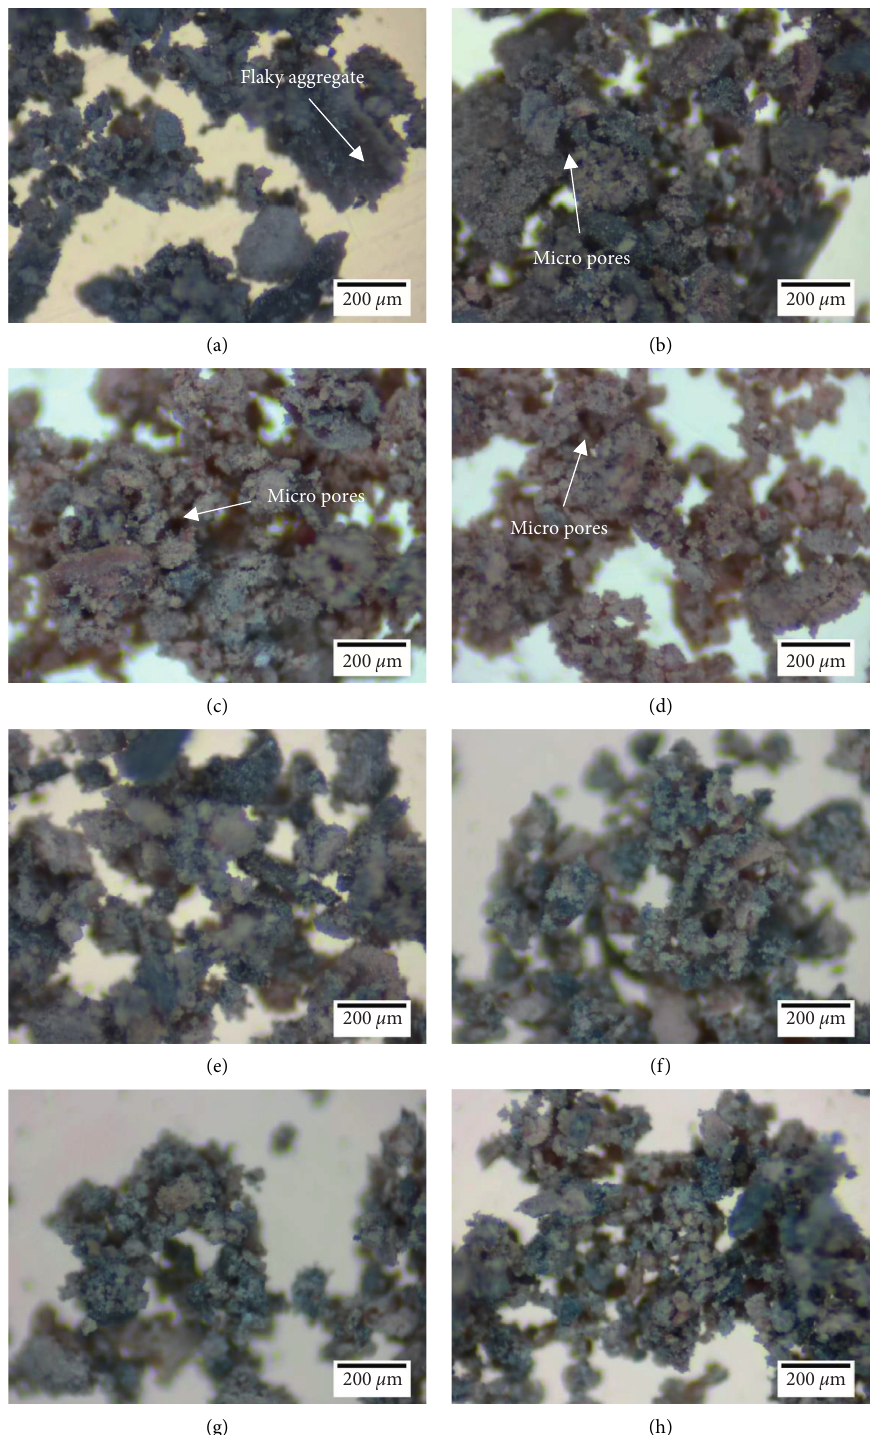
Figure 4: Evolution of microstructure of slaking mudstone at × 400 magnification. (a) 5min, P / D � 0.04; (b) 10min, P / D � 0.06; (c) 15min, P / D � 0.07; (d) 20min, P / D � 0.09; (e) 30min, P / D � 0.13; (f) 40min, P / D � 0.15; (g) 50min, P / D � 0.17; (h) 60min, P / D � argillization wear stage, and secondary wear stage. The of slacking mudstone stage, and adhesion of slacking mudstone mechanisms of argillization and cutter wear considering stage. Correspondingly, due to the argillization in mudstone, argillization at each stage are revealed. the disc cutter wear goes through the mechanical wear stage,